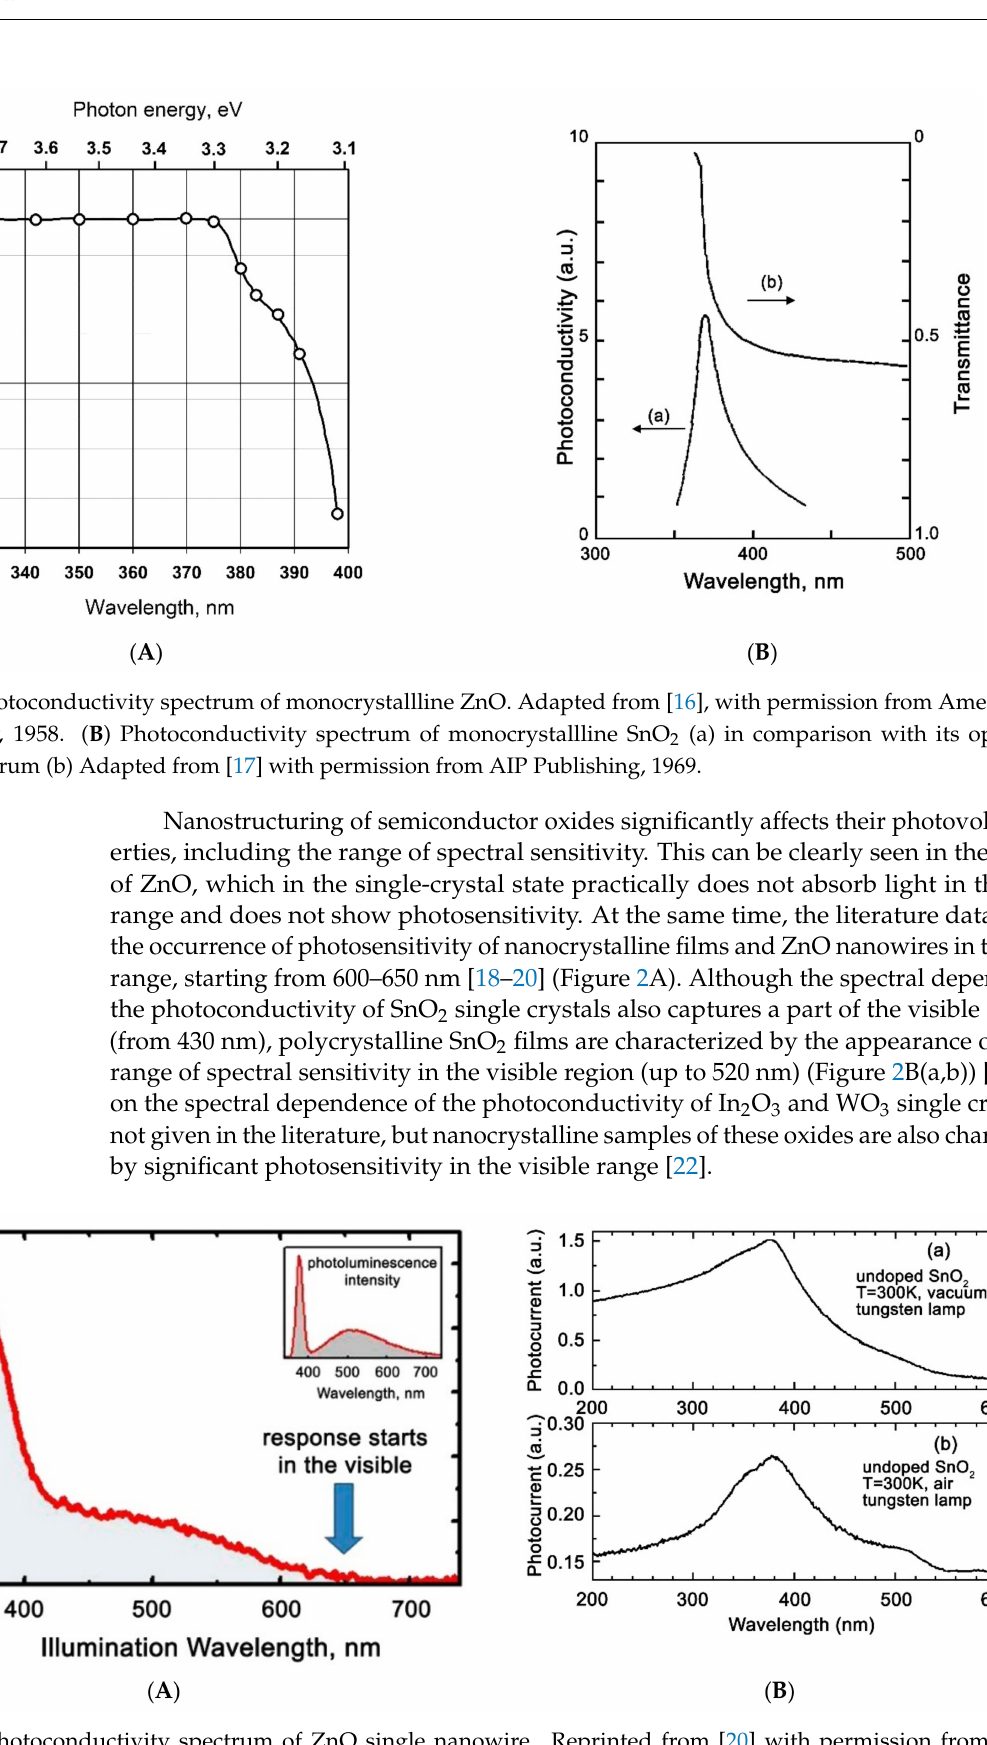
Figure 2. ( A ) Photoconductivity spectrum of ZnO single nanowire. Reprinted from [20] with permission from AIP Publishing, 2014. ( B ) Photoconductivity spectrum of nanocrystallline SnO 2 in vacuum (a) and in air (b). Reprinted from [21] with permission from Taylor & Francis,